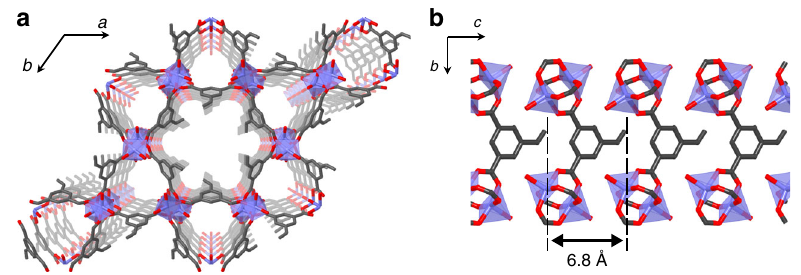
Fig. 2 Crystal structure of host PCP. Views of the nanochannel structure of 1S ⊃ H 2 O along the c -axis ( a ) and a -axis ( b ). Atoms: Cu (purple), O (red), C (grey). Styryl groups are periodically aligned along the c -axis at a distance of 6.8 Å on each face of the hexagonal channel. H atoms and one of the disordered vinyl moieties have been omitted for clarity